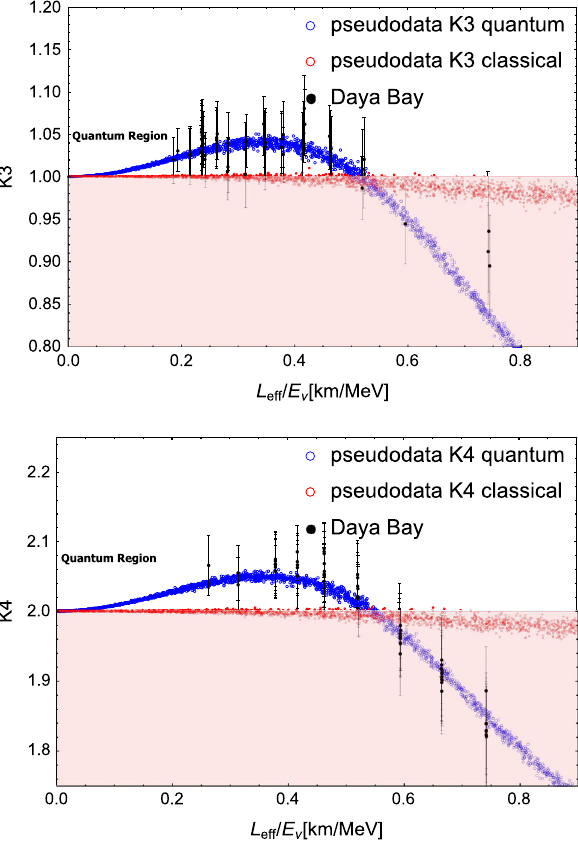
Fig. 4 The distribution of K3 (upper) and K4 (lower) versus the effec- tive propagation length divided by neutrino energy reconstructed from P ee . The black dot data show a cluster over the LGI bound. We also show the expected distributions of classical (red circles) and quantum (blue circle) predictions. Note that the K 3 and K 4 can be multiple val- ues, since there are many triples and quadruples satisfying the phase sum